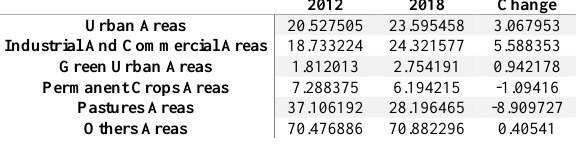
Table 3. Area changes in land classes according to Urban Atlas